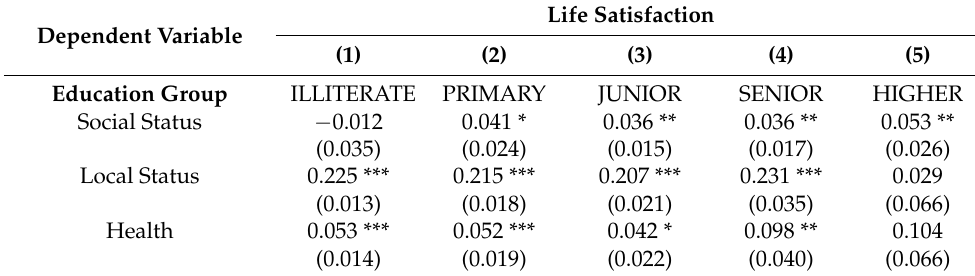
Table A2. Effects over social